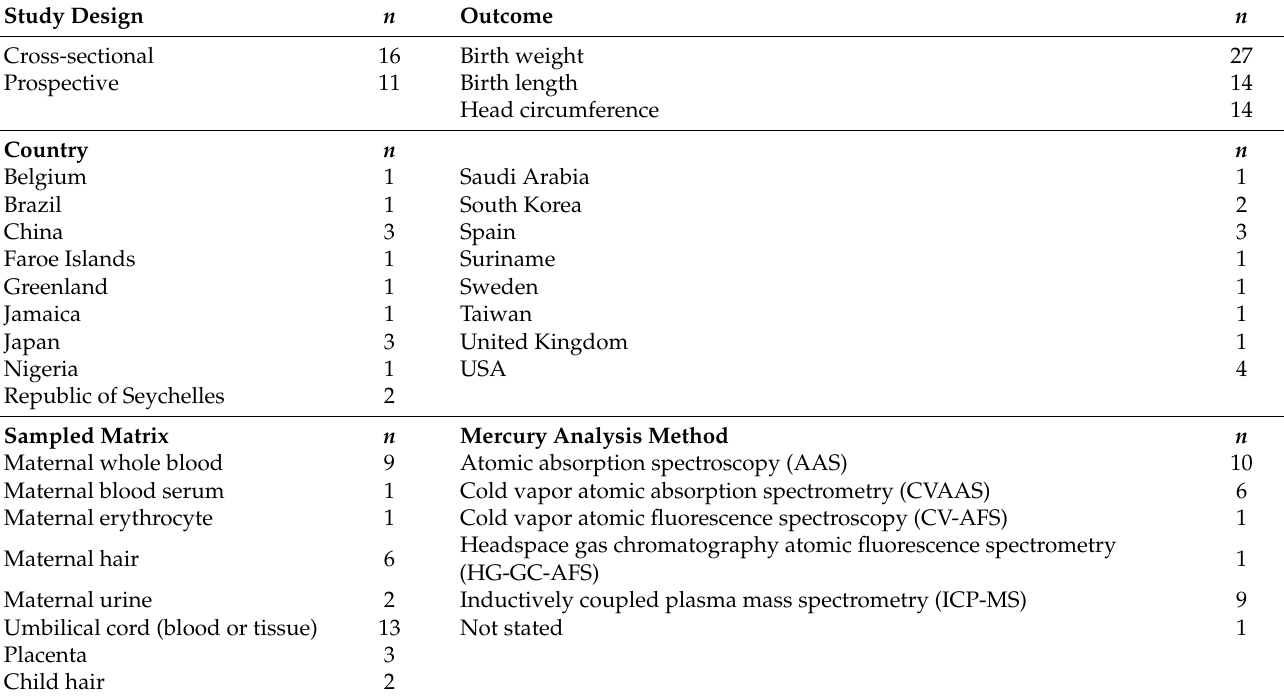
Figure 1. PRISMA flow diagram of search and selection process. Table 2. Study characteristics (Studies may be counted in multiple categories).